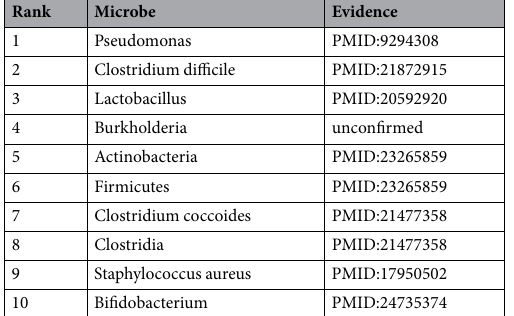
Table 1. In the case study of asthma, 9 out of top-10 predicted microbes have been supported by literature evidences.